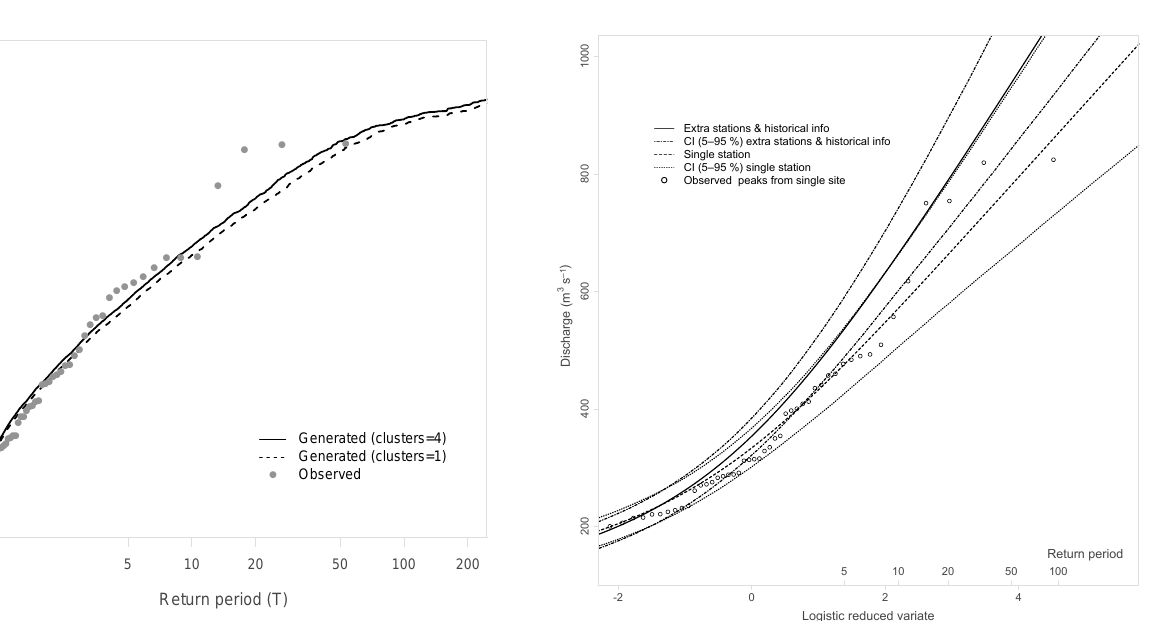
Figure 4. Flood frequency curves with 95% confidence limits for the single-site data and the multi-site data with the extra information case. Observed peaks are also plotted with the Gringorten plotting